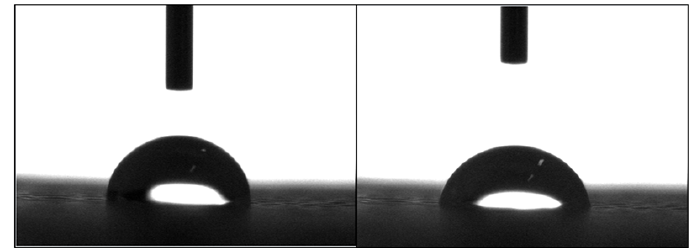
Figure 3. Water drop on a PCL scaffold filament at 0 s ( left ) and 20 s ( right ) .